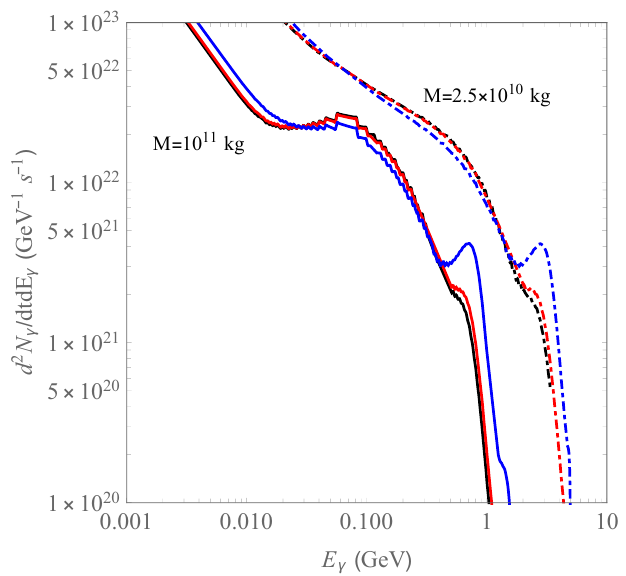
Figure 4 . Photon spectrum for PBHs with ˜ a = 0 , 0 . 2 , 0 . 5 (black, red and blue, respectively) and for M = 2 . 5 × 10 10 and 10 11 kg (dashed-dotted and solid lines, respectively), obtained using BlackHawk/Hazma.